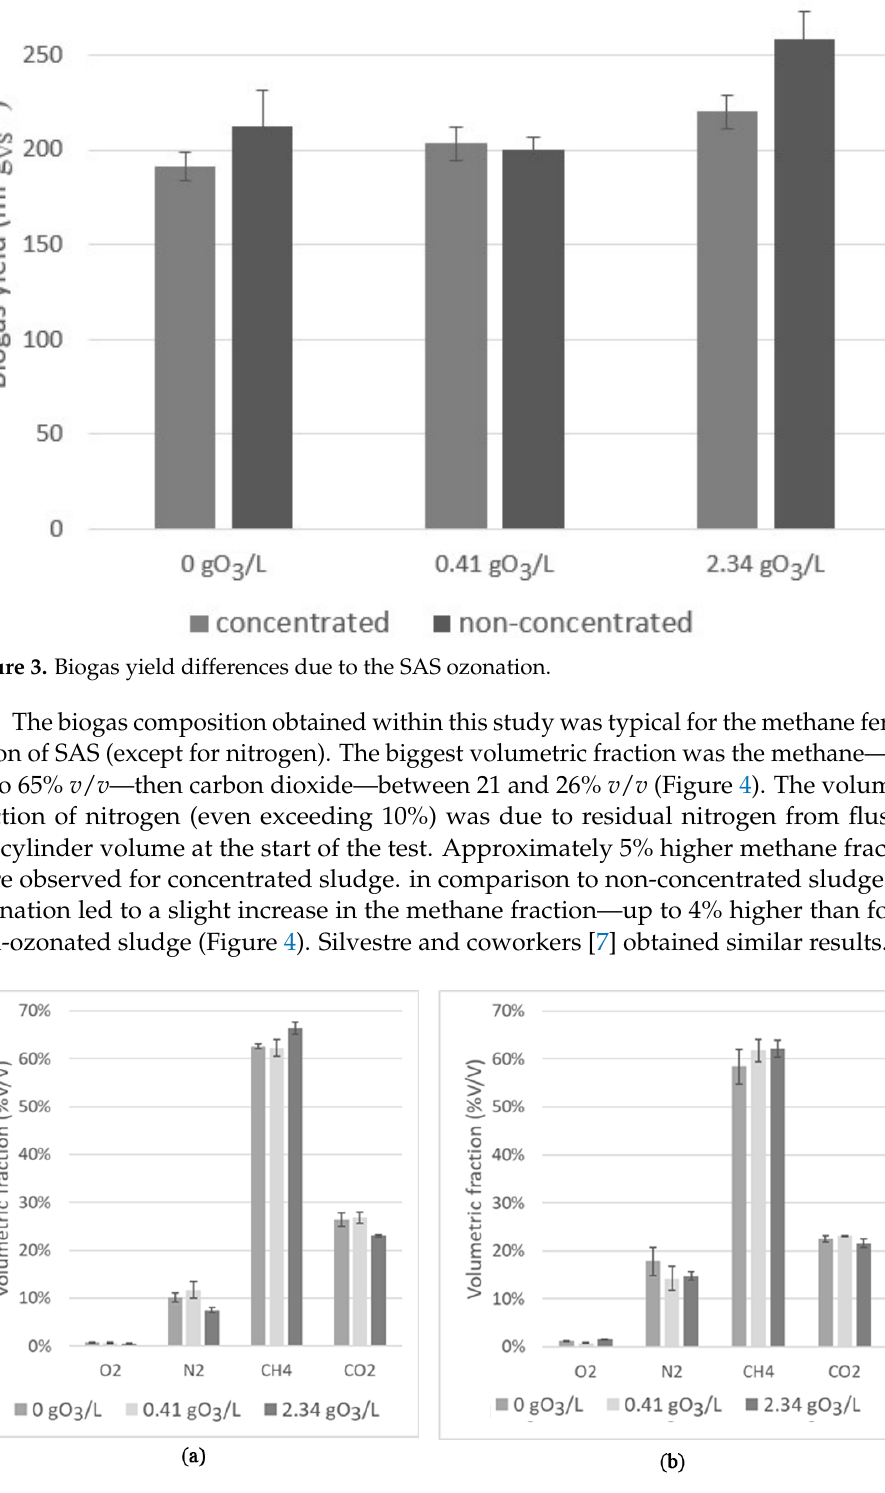
Figure 4. Biogas composition obtained within fermentation processes: ( a ) concentrated SAS; ( b ) non ‐ concentrated SAS.